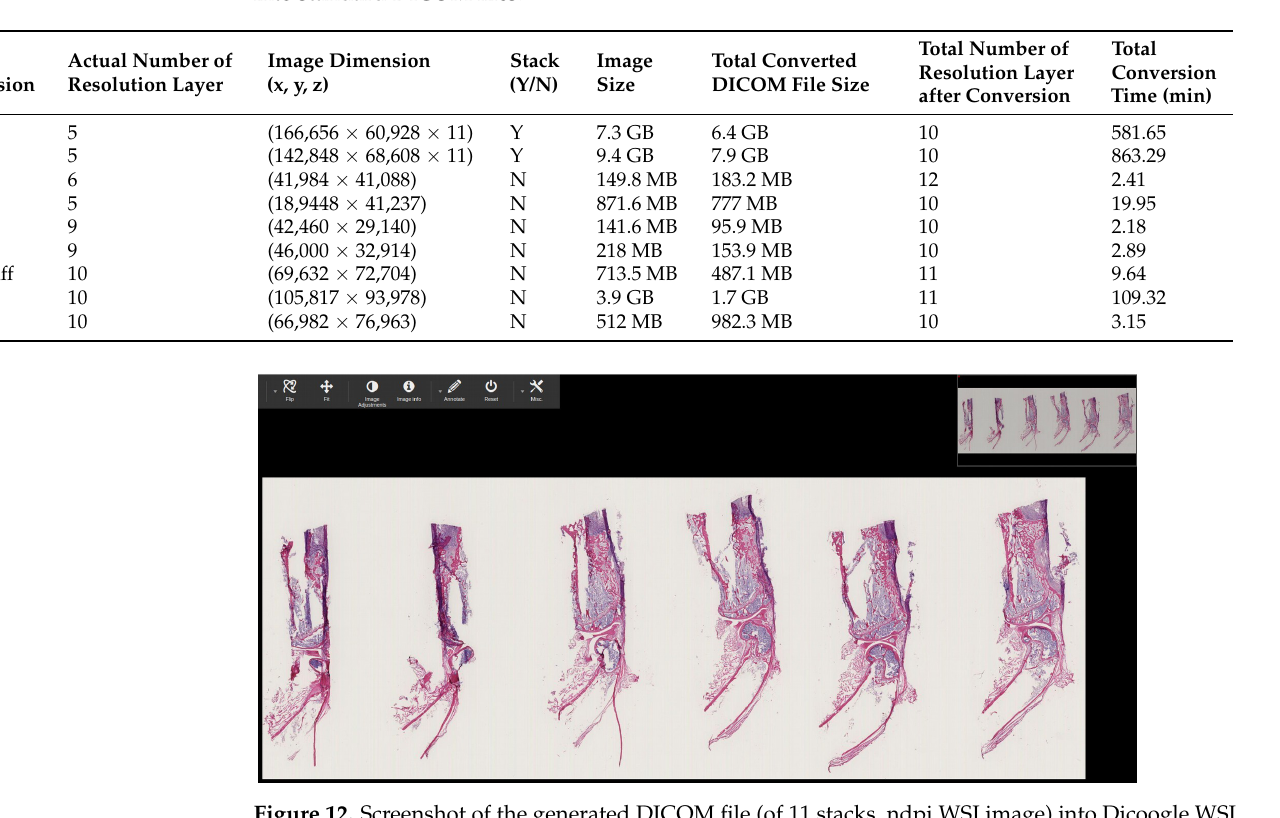
Table 5. Proposed WSI framework performance while converting eight distinct proprietary WSI files into standard DICOM files.